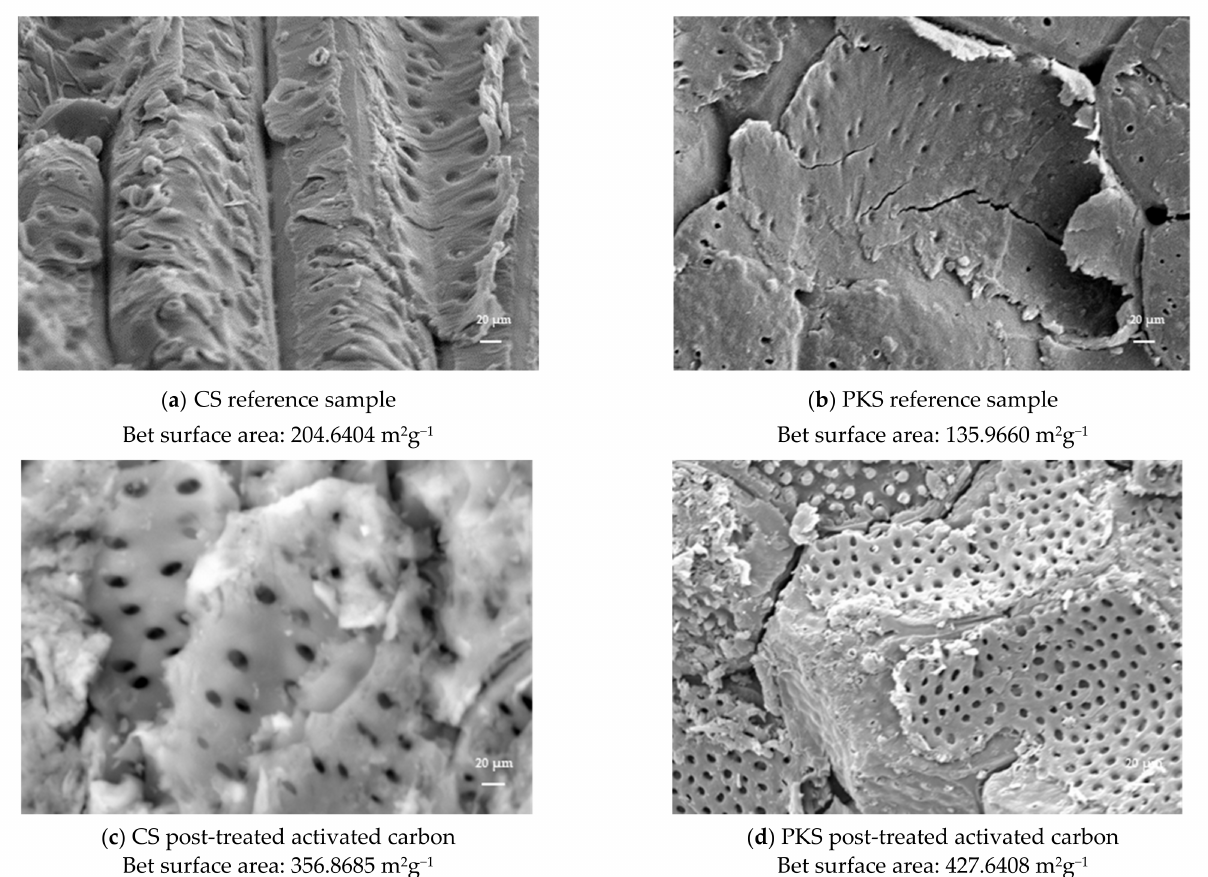
Figure 6. Scanning electron micrographs of ( a , b ) activated carbons prepared at 700 ◦ C for 75 min and ( c , d ) activated carbon (700 ◦ C, 75 min) post-treated with 25% NaOH at 2000 ×